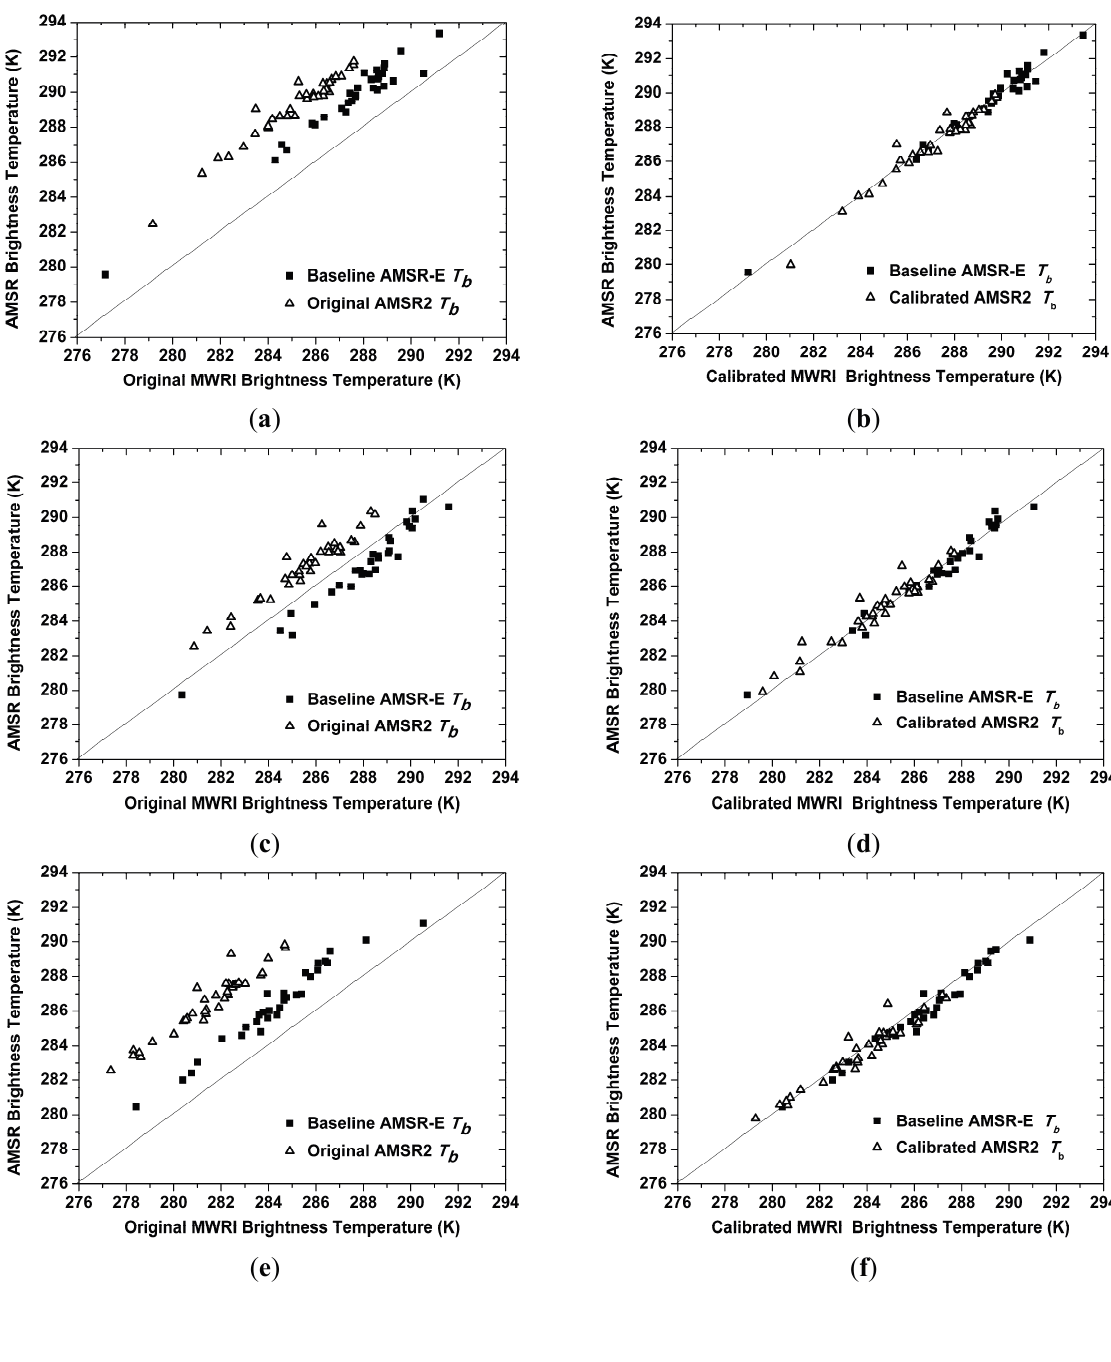
comparisons from overlapping MWRI and AMSR ascending orbit Figure 6. H-Polarized T b observations for the selected Amazon tropical reference area; the comparisons represent both ( left panel ) original uncalibrated and ( right panel ) calibrated ( a , b ) 23 GHz ( c , d ) 18 GHz results relative to the AMSR-E baseline for 23 GHz, ( e , f ) 10 GHz MWRI and AMSR2 T b 18 GHz and 10 GHz